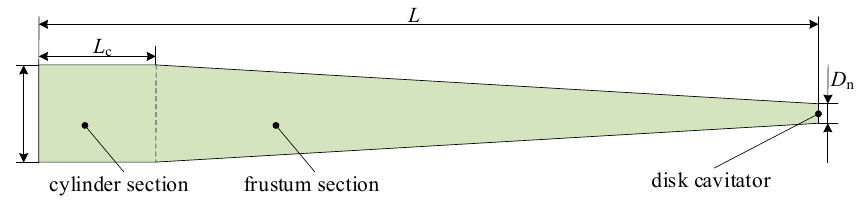
Figure 2. Layout and geometric parameters of supercavitating projectile.